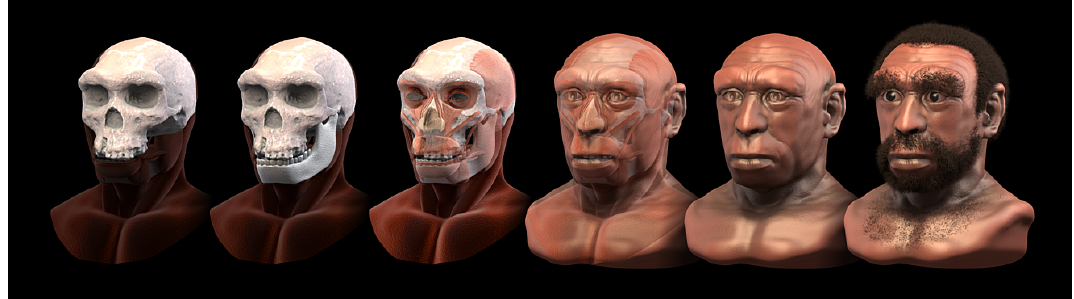
Figure 8. Forensic facial reconstruction is probably the most subjective, and one of the most controversial, techniques in the Forensic Anthropology (FA) field. In addition to remains involved in criminal investigations, facial reconstructions are created for remains believed to be of historical value and for remains of prehistoric hominids and humans. In particular, this figure displays the facial reconstruction of the Homo Heidelbergensis. Image taken from Wikimedia